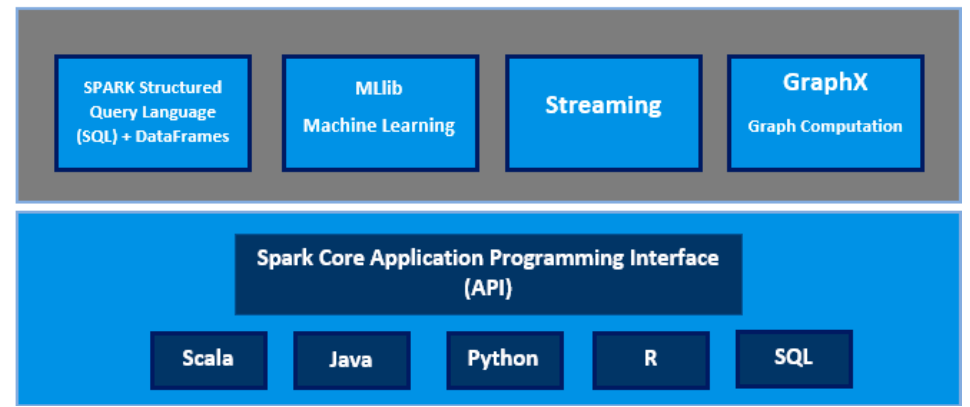
Figure 1. Apache Spark Ecosystem [19].